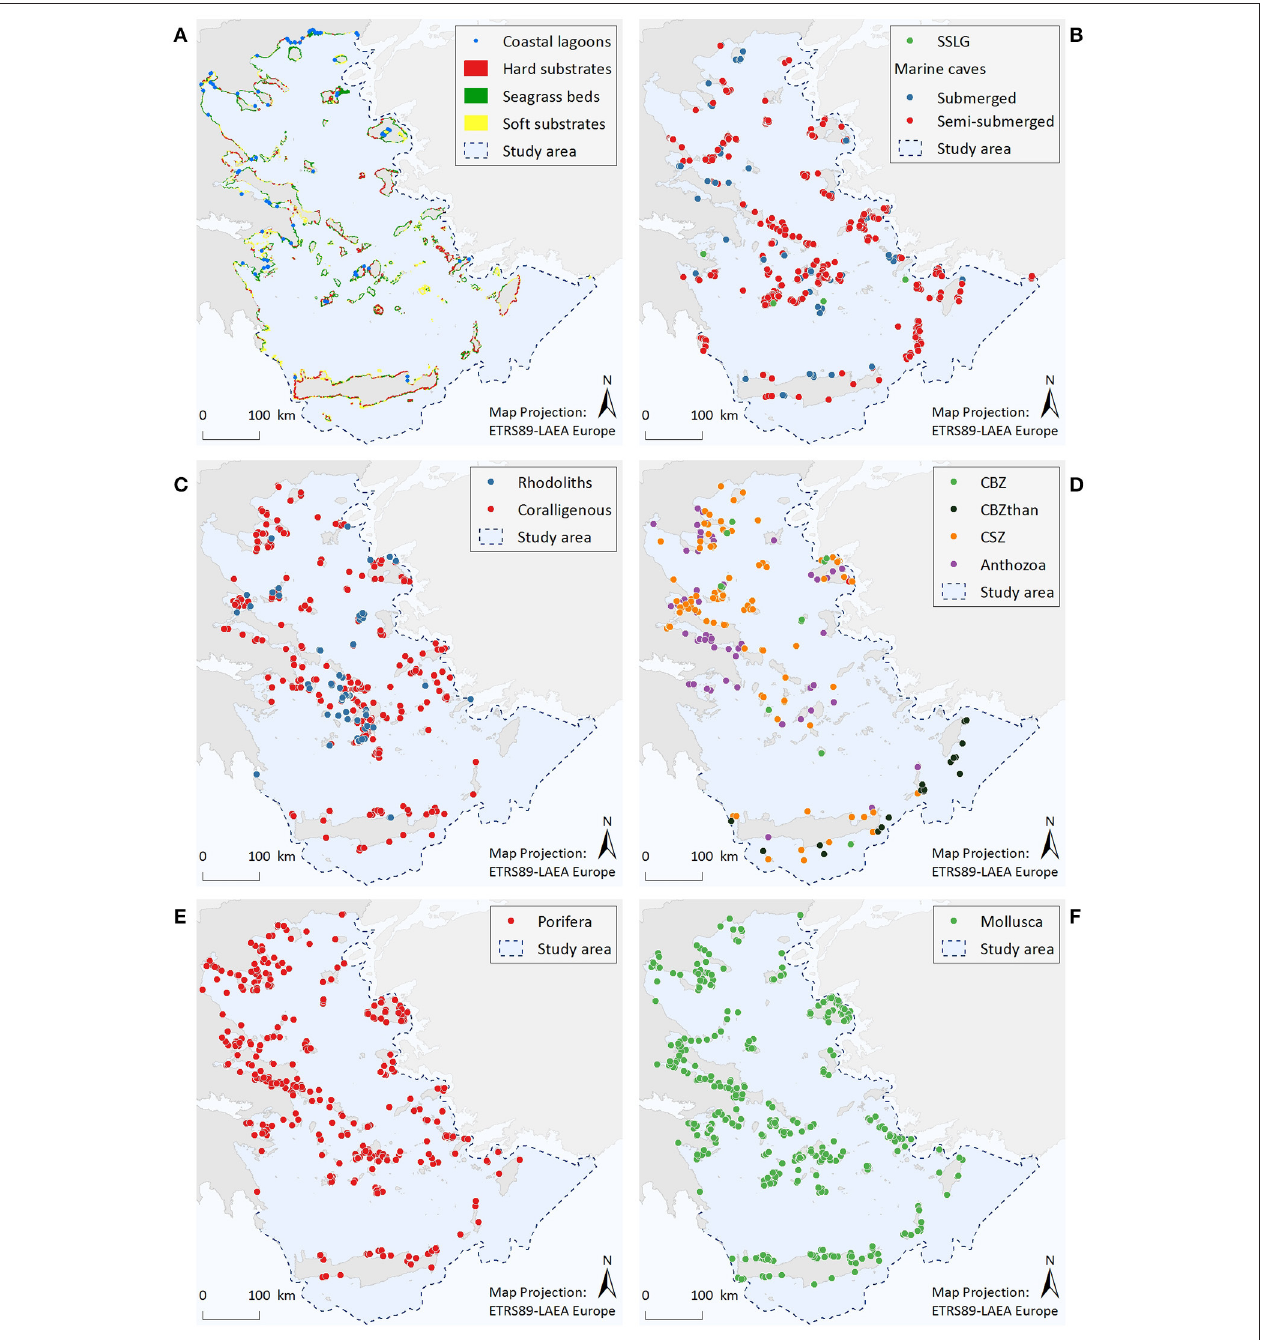
FIGURE 2 | Illustrative maps depicting the distribution of (A) Coastal lagoons, hard substrates, seagrass beds, and soft substrates, (B) Submarine structures made by leaking gases (SSLG) and marine caves, (C) Rhodolith beds and coralligenous formations, (D) Corals of the bathyal zone (CBZ), Corals of the bathyal zone thanatocoenoses (CBZthan), Corals of the sublittoral zone (CSZ), and Anthozoa, (E) Porifera, (F) Mollusca.